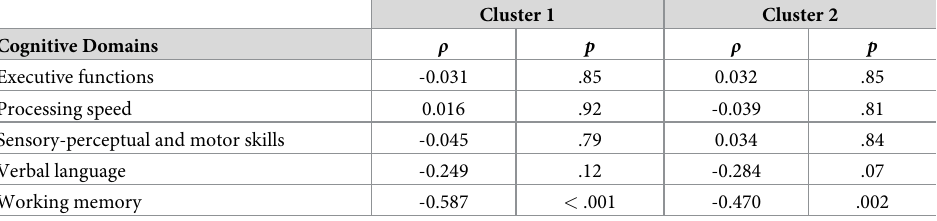
Table 5. Correlations between the performance of cognitive domains and the cortical thickness of the